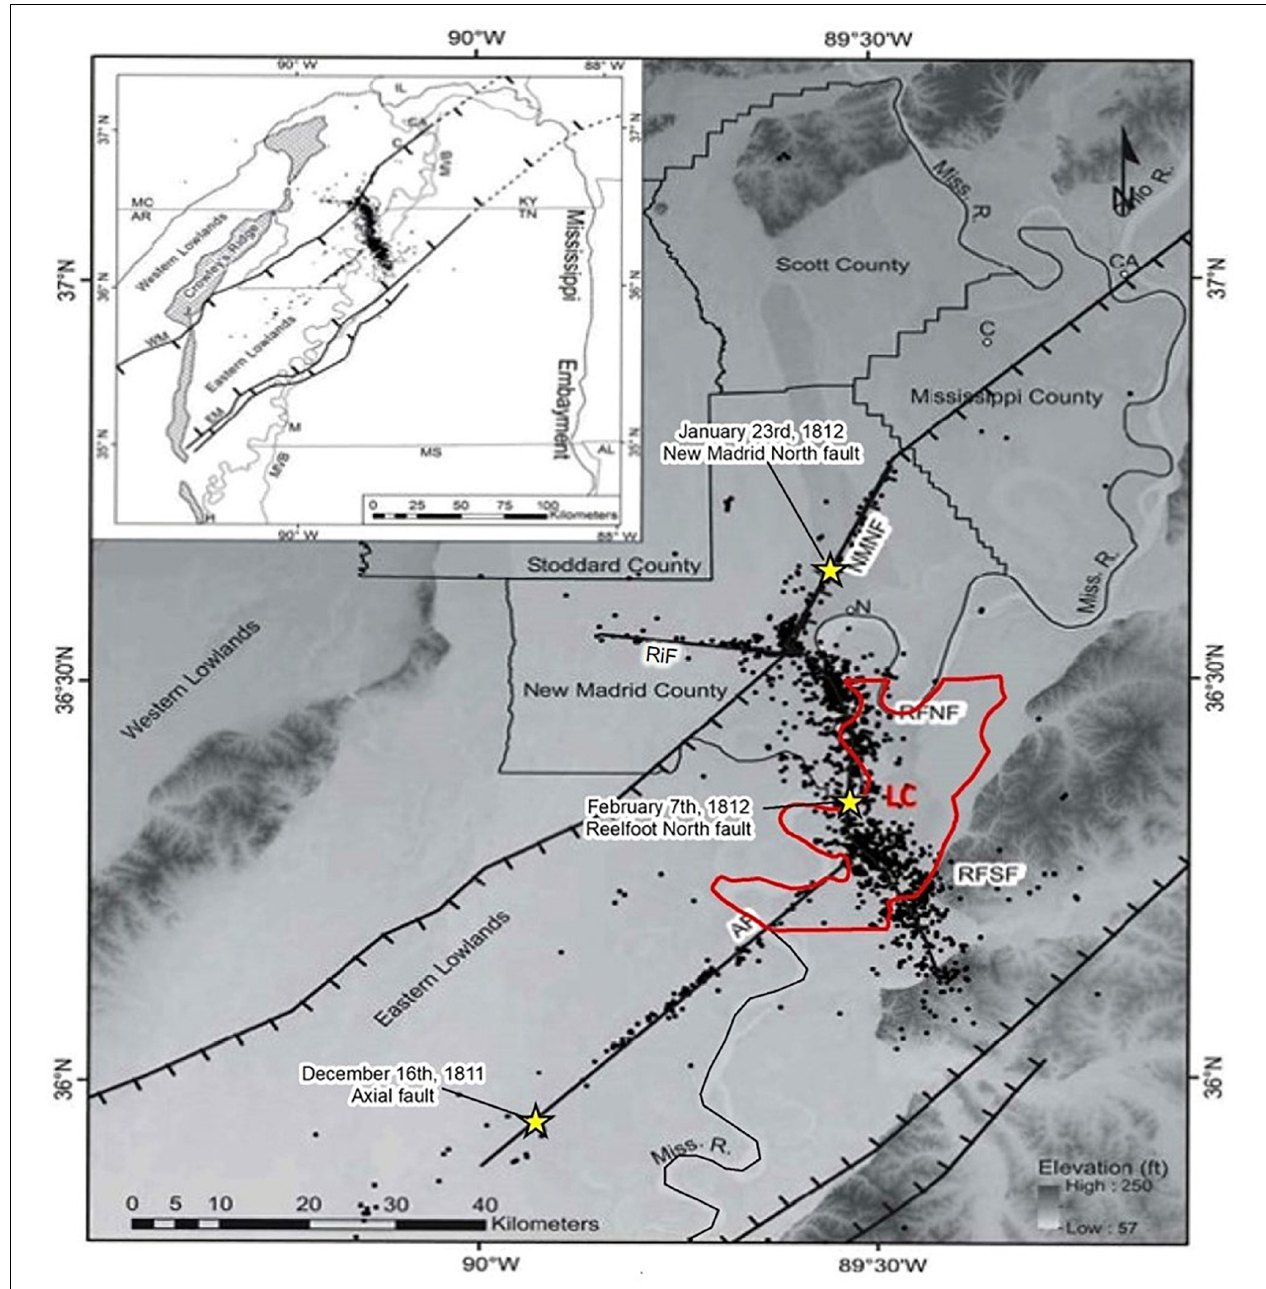
FIGURE 1 | Earthquakes recorded between 1979 and 2006 in the New Madrid seismic zone (CERI Earthquake Catalog) are illustrated as black dots, with the approximate locations of the three very large 1811–1812 earthquakes as stars. LC, Lake County; AF, Axial fault; CA, Cairo, Illinois; C, Charleston, Missouri; N, New Madrid, Missouri; NMNF, New Madrid North fault; RiF, Risco fault (New Madrid West fault); RFNF, Reelfoot North fault; and RFSF, Reelfoot South fault. Inset box shows Mississippi embayment and Mississippi River valley area. EM, Eastern Reelfoot rift margin; H, Helena, Arkansas; M, Memphis, Tennessee; MVB, Mississippi River valley bluffs; WM, Western Reelfoot rift margin. The inset map also shows the New Madrid seismic zone of northwest Tennessee, southeast Missouri, and northeast Arkansas within the northern Mississippi embayment [modified from Pryne et al. (2013)].